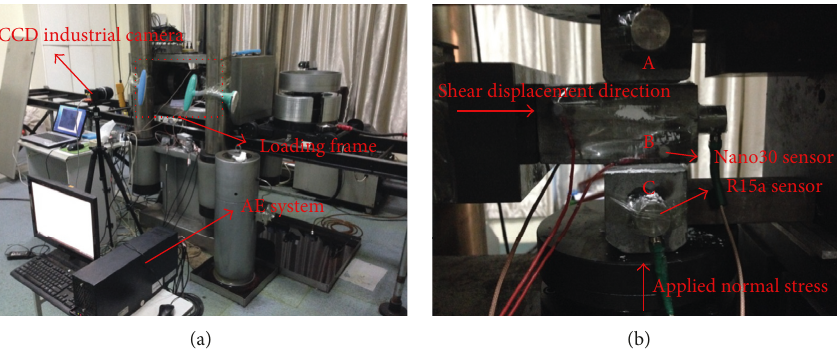
Figure 1: Testing system and the assemblage of forcing blocks. Note: the upper and lower forcing blocks were each assigned a R15a AE sensor. The center block contained a total of three Nano30 and one R15a AE sensors. (a) Layout of the testing system. (b) Assemblage of the three forcing blocks and AE sensors arrangement.